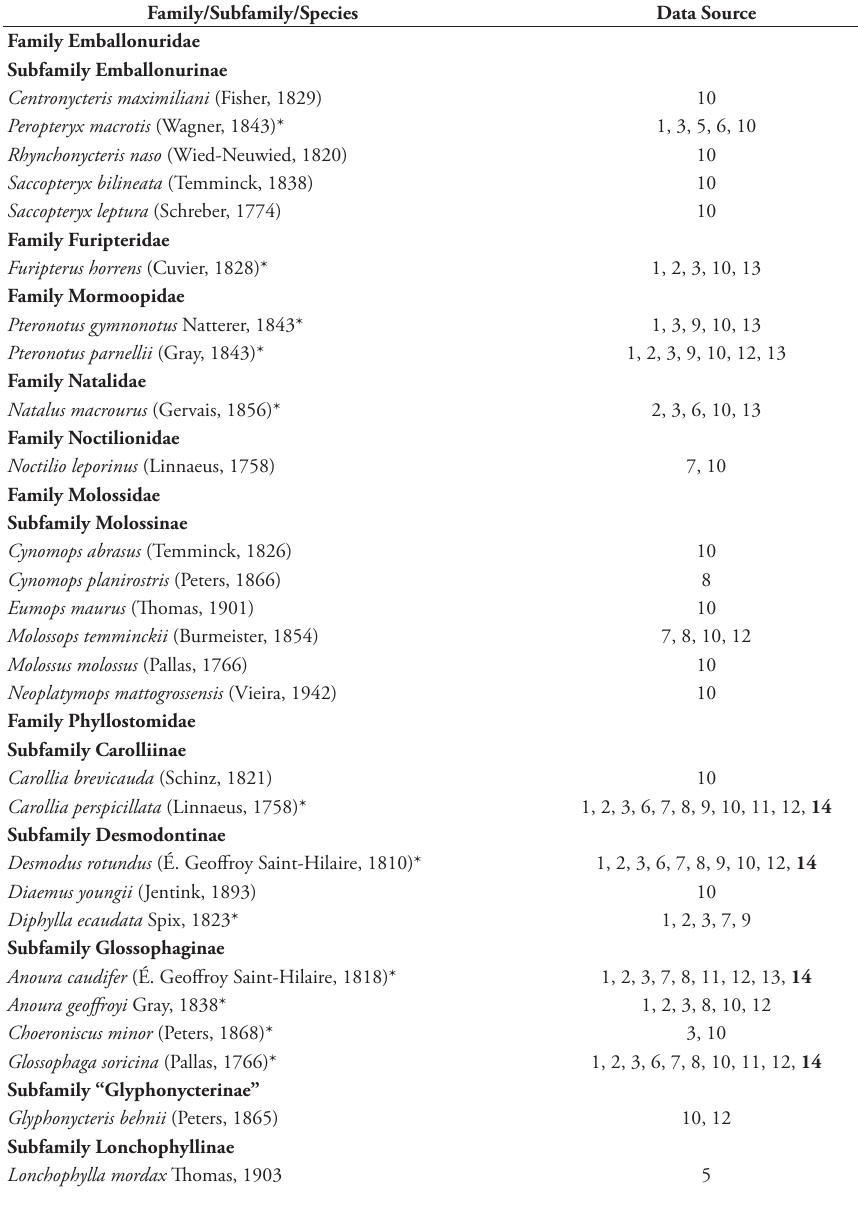
Table 1. Checklist of bats recorded in Distrito Federal and Goiás state. Source: 1 - Bredt et al. (1999), 2 - Esbérard et al. (2001), 3 - Esbérard et al. (2005), 4 - Zortéa and Tomaz (2006), 5 - Reis et al. (2007), 6 - Silva et al. (2009), 7 - Bezerra and Marinho-Filho 2010, 8 - Zortéa et al. (2010), 9 - Chaves et al. (2012), 10 - Reis et al. (2013), 11 - LESV, 12 - Zortéa and Alho (2008), 13 - Guimarães (2014), 14 – Present study . * Species recorded in